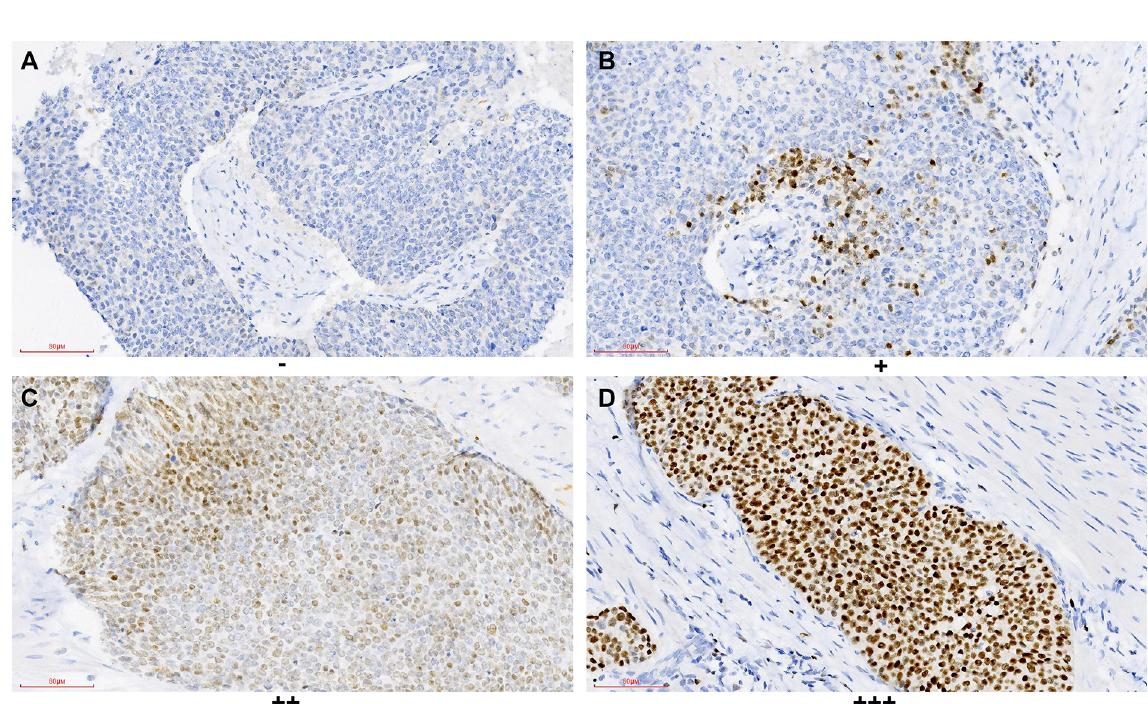
Figure 3. NUSAP1 expression in BUC tissues; strong staining for NUSAP1 was mostly observed in tissues with high-grade, high staged, and lymph node metastasis-positive specimens